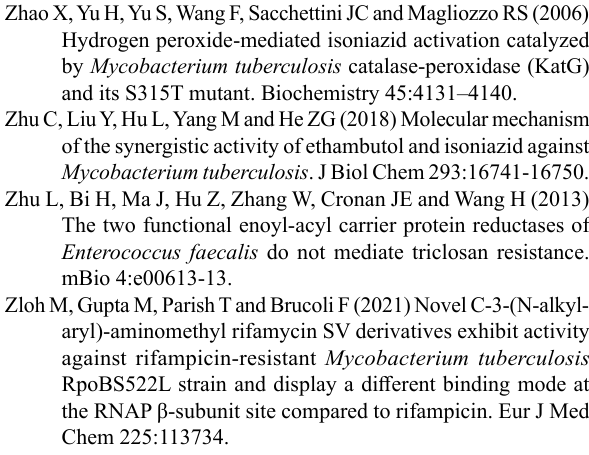
Table S1 - Novel KatG mutations. Table S2 - Novel RpoB mutations. Table S3 - Novel PncA mutations. Table S4 - Novel EmbC, EmbA, EmbB